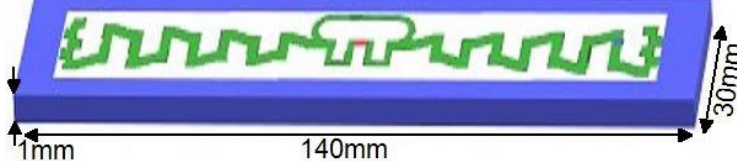
Figure 14. Simulation model for all platforms (140 mm × 30 mm × 1mm) w.r.t. the RFID tag. Table 5. Dielectric properties of the mounting platforms [31].